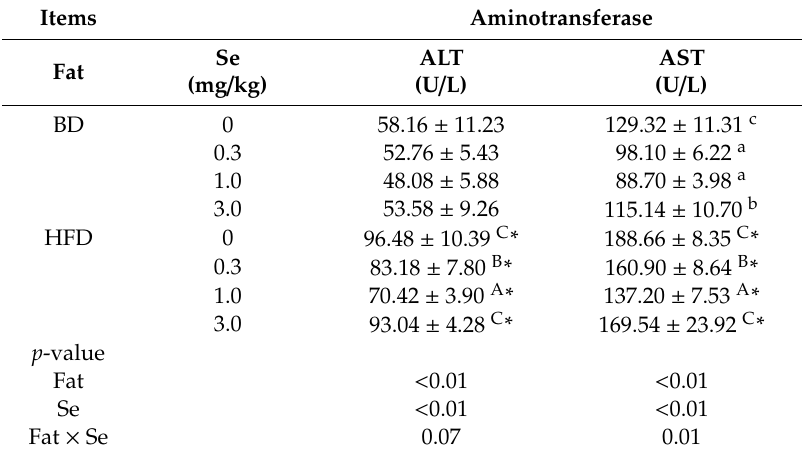
Table 4. Results of the levels of ALT and AST in the